Question: What does this figure show? Answer in one sentence.
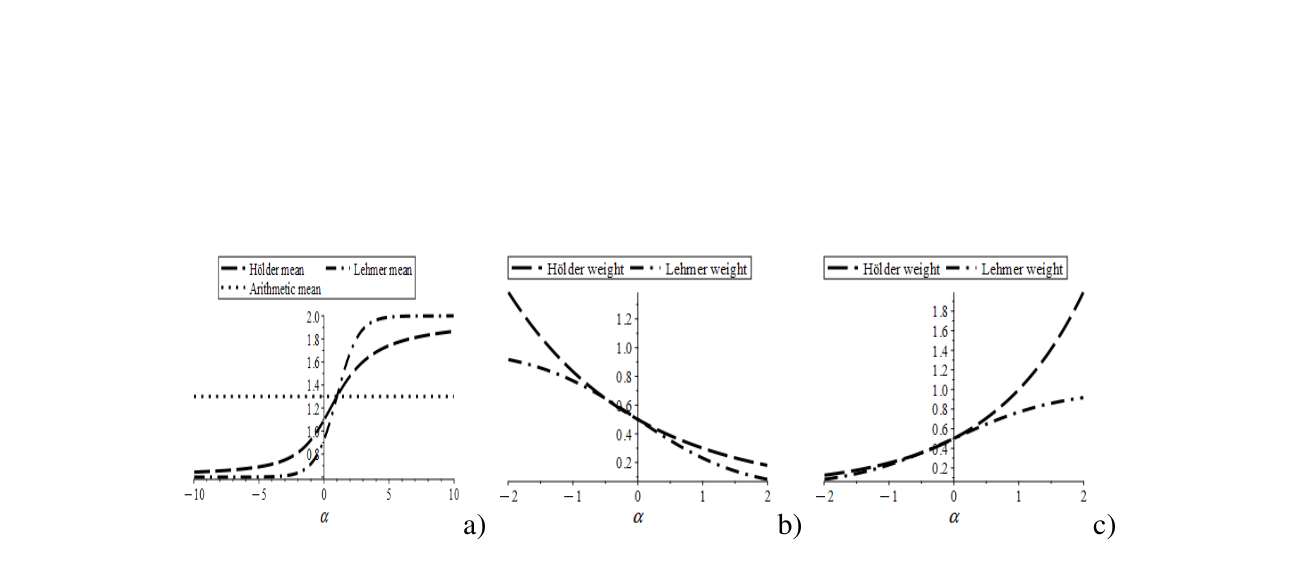
Answer: (a) Three means between 0.6 and 2 as function of α. The arithmetic mean is displayed as a basis for comparison. (b) The weights mh(0.6) and ml(0.6) as a function of α. (c) The weights mh(2) and ml(2) as a function of α.